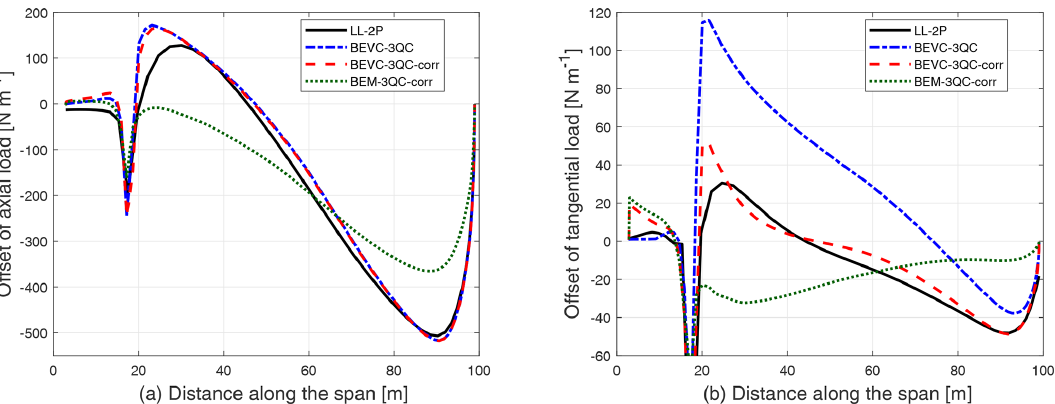
Figure 16. Comparison of the difference in axial load (a) and tangential load (b) of the straight blade with 15 ◦ of downwind coning compared to the straight blade without coning calculated from LL-2P, BEVC with and without the correction (BEVC-3QC-corr, BEVC-3QC), and the BEM method with the correction